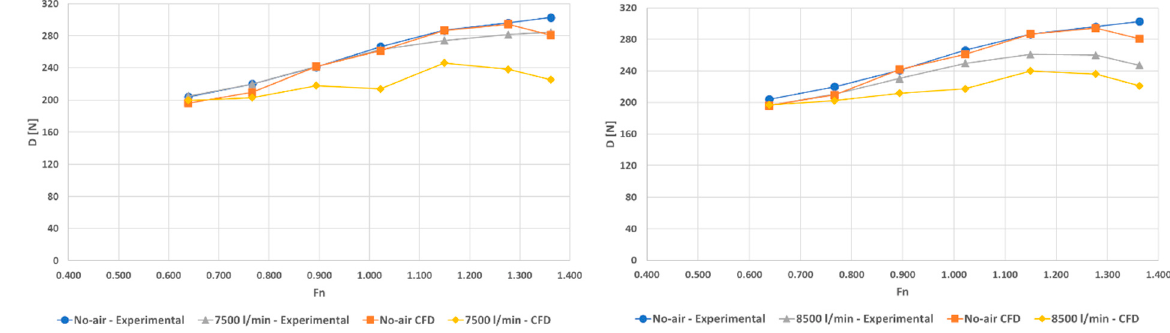
Figure 15. Wetted surface comparison–Air (5500 L/minans 6500 L/min) and No air.